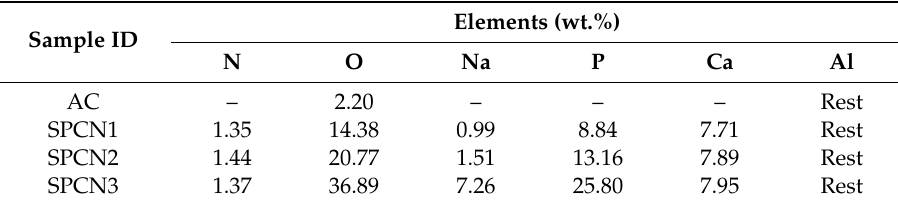
Table 1. Energy-dispersive X-ray spectroscopy (EDS) analysis of